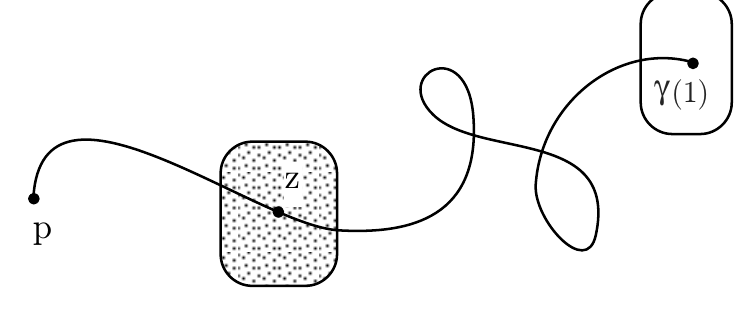
Fig. 2 – Varying g at a free spot z controls the endpoint q = γ ( 1 ) of the geodesic γ